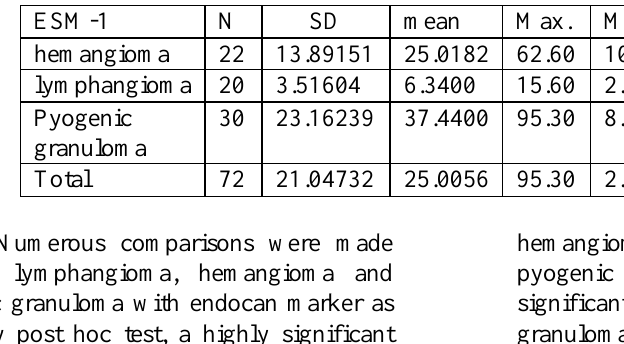
Table (1): Description of statistics gained by immunohistochemistry of ESM-1